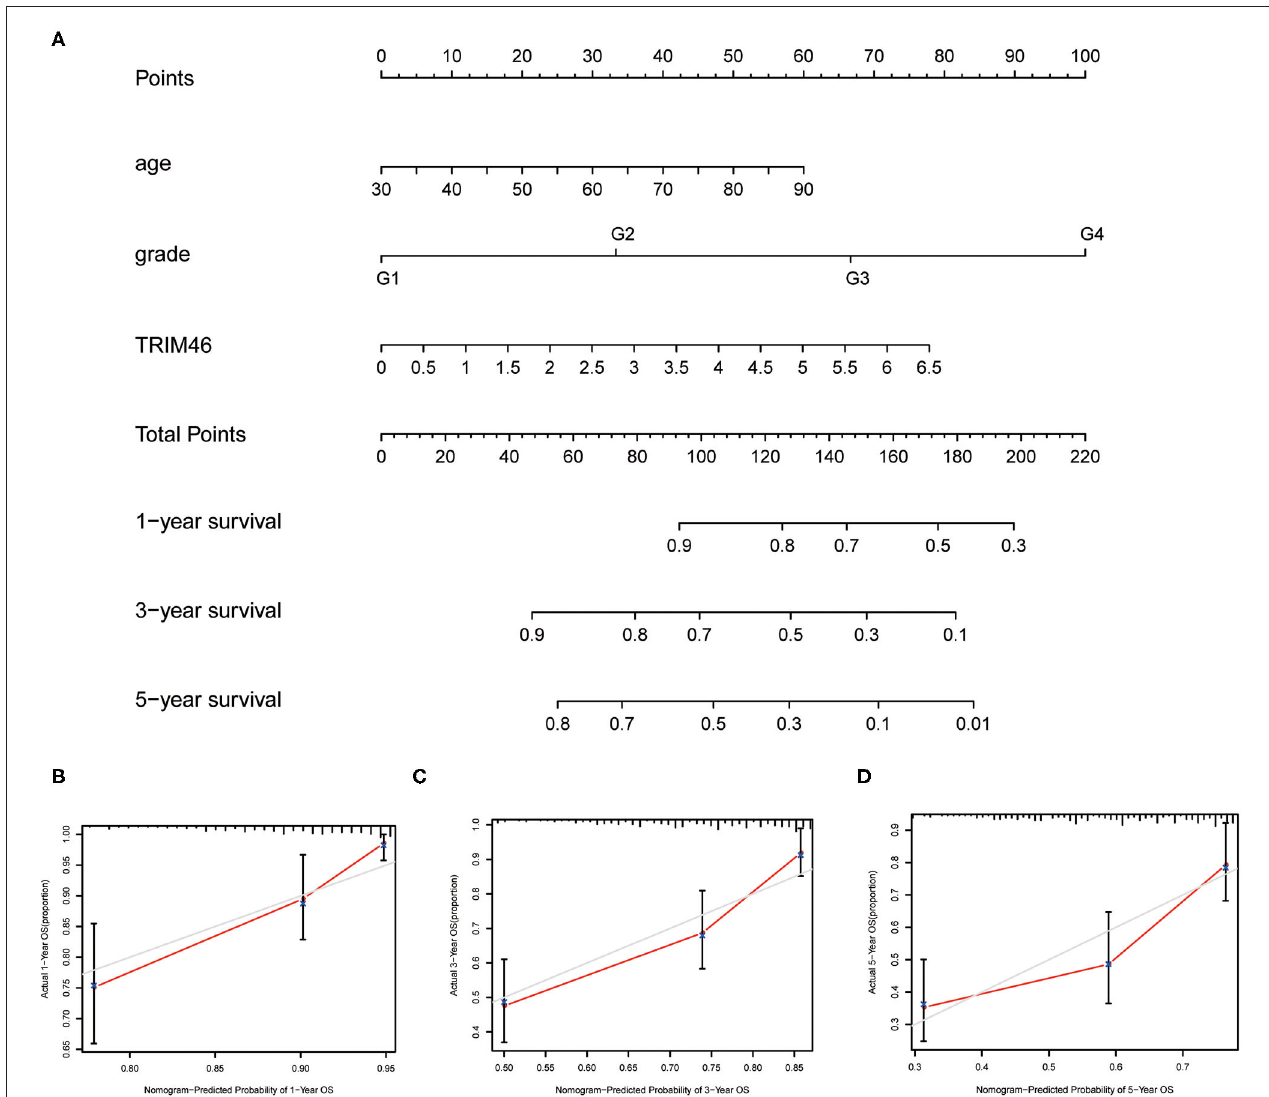
FIGURE 4 | The prognostic value of several factors in a nomogram. (A) Construction of a predictive nomogram. (B–D) Actual and predicted survivals were shown by the use of calibration